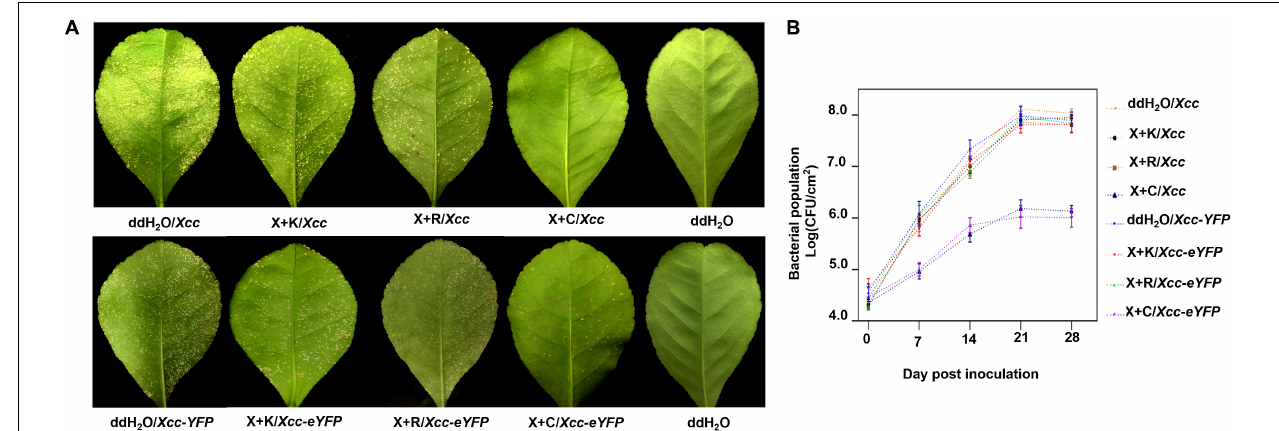
FIGURE 6 | Outdoor prevention effect of the mixture formulation of bactericides against CBC. (A) Images represent the development of citrus canker symptoms spray-inoculated by Xcc and Xcc-eYFP [about 5 × 10 8 colony-forming units/ml (CFU/ml)] and the corresponding bactericides 28 days postinoculation. (B) The bacterial growth curve of Xcc and Xcc-eYFP strain populations on Lemon leaves above. Xc c and Xcc-eYFP bacterial cells were extracted from the leaves at different time points after inoculation and quantified using the bacterial counting plate method and bacterial fluorescence spot counting method. The values shown are the means of five repeats and SDs. All assays were repeated three times with similar results. X + C: 1:1 mixture formulation of 1.2% xinjunan acetate (AS) and 30% copper oxychloride (SC); X + K: 1:1 mixture formulation of 1.2% xinjunan acetate (AS) and 33% kasugamycin xine-copper (SC); X + R:1:1 mixture formulation of 1.2% xinjunan acetate (AS) and 20% resin acid copper (EW); ddH 2 O: double-distilled